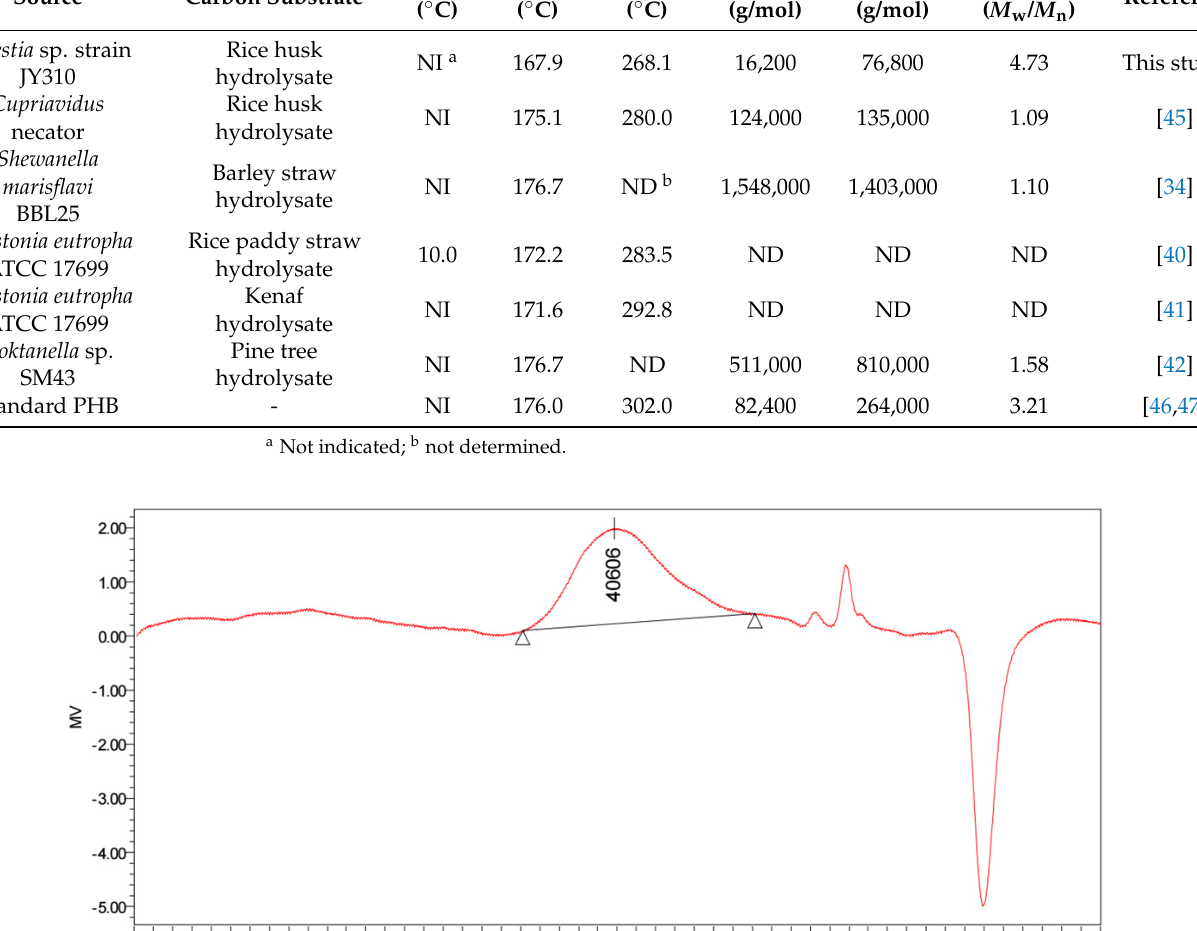
Table 2). The molecular weight and molecular weight distribution of the PHB were